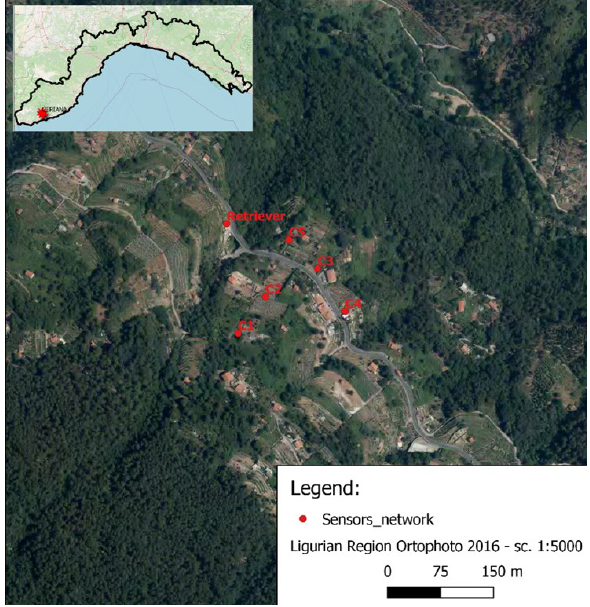
Figure 4. Overview of Ceriana-Mainardo and the soil moisture monitoring network.